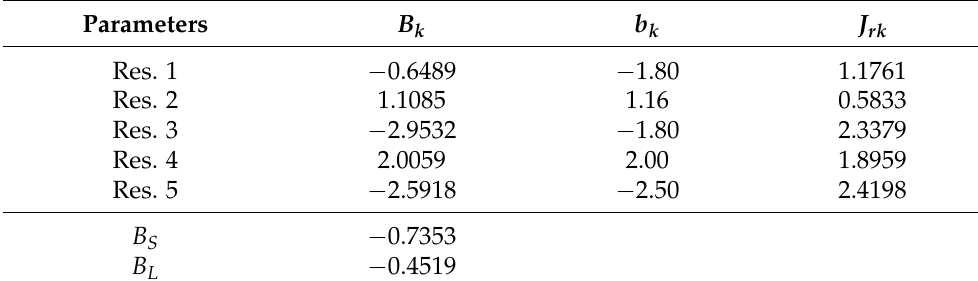
Table 2. Extracted elements of the 5th-order filter prototype with Ω Ck TZs distribution.